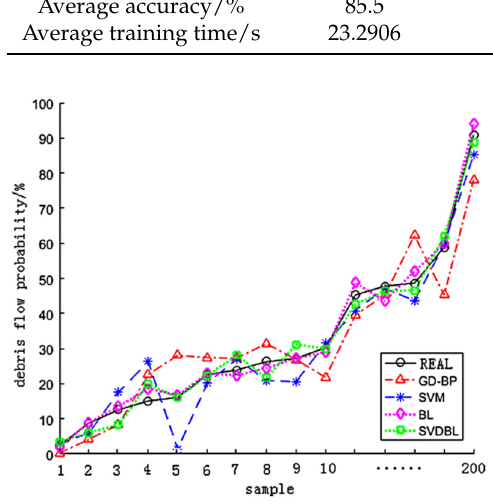
Figure 11. Forecast results of four models.